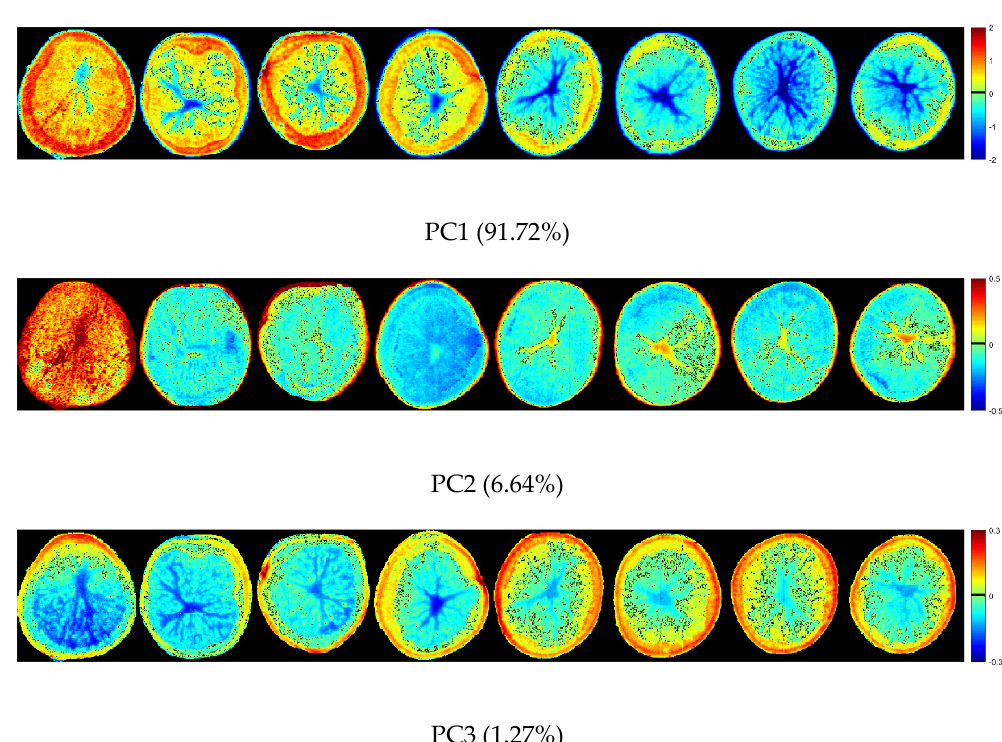
Figure 3. Scores images of the first three PCs (the concentration of the sodium pyrosulfite solution were: 0% (distilled water), 0.05%, 0.1%, 0.3%, 0.5%, 1%, 2% and 3%).